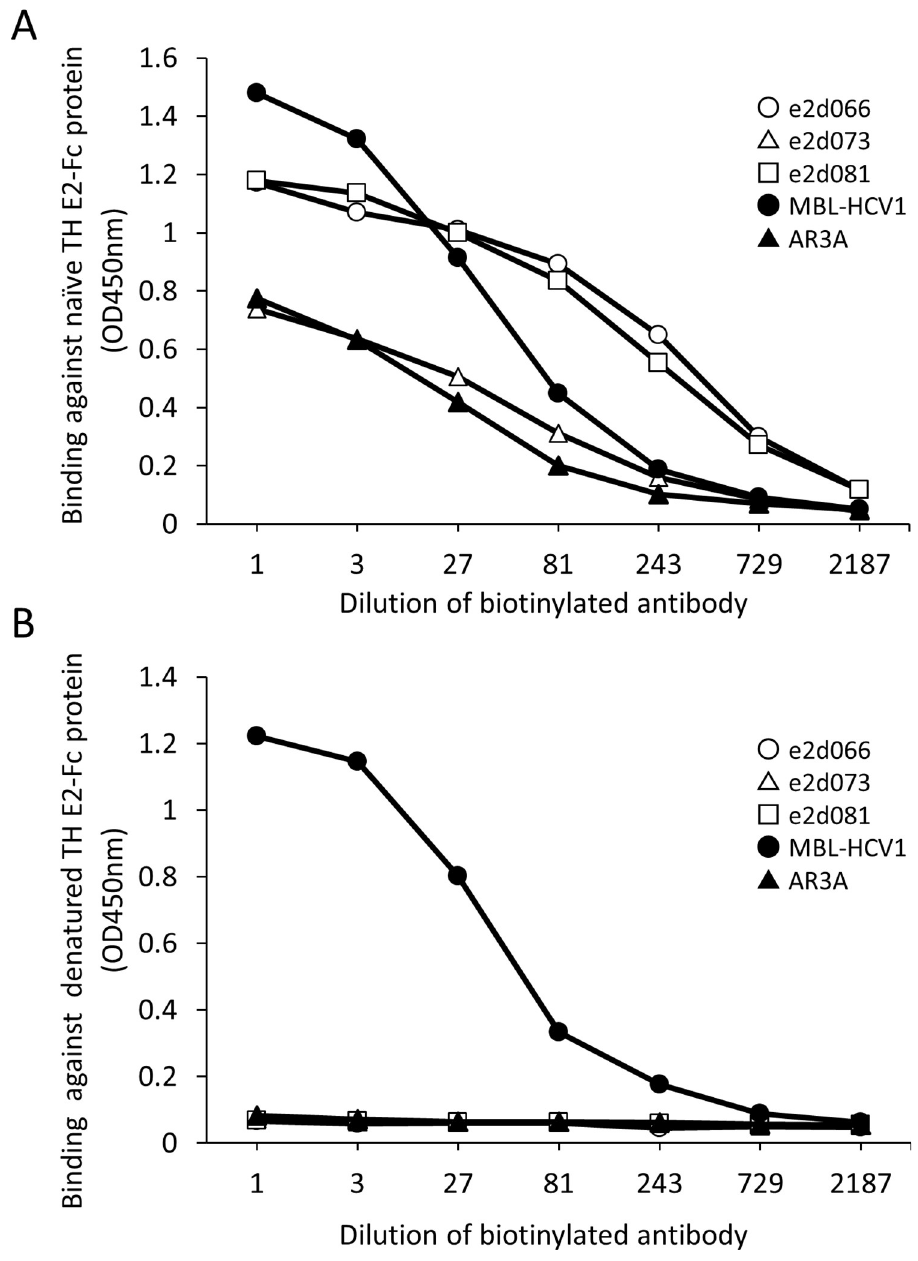
Fig 3. Antibody binding against na ï ve and denatured genotype 1b envelope E2 protein. (A) Na ï ve and (B) denatured recombinant THE2-Fc proteins were used to coat Nunc-Immune plates (Thermo Fisher Scientific). Biotinylated anti-E2 antibodies were distributed to the prepared plates. Binding of biotinylated anti-E2 antibodies to the coated plates then was assessed using Streptavidin-HRP (GE Healthcare). The titers of antibodies were measured using a peroxidase assay kit for ELISA (Sumitomo Bakelite Co., Ltd.). Open-circle: e2d066 IgG, open-triangle: e2d073 IgG, open-square: e2d081 IgG, filled-circle: MBL-HCV1 (linear epitope control antibody), filled-triangle: AR3A (conformational epitope control